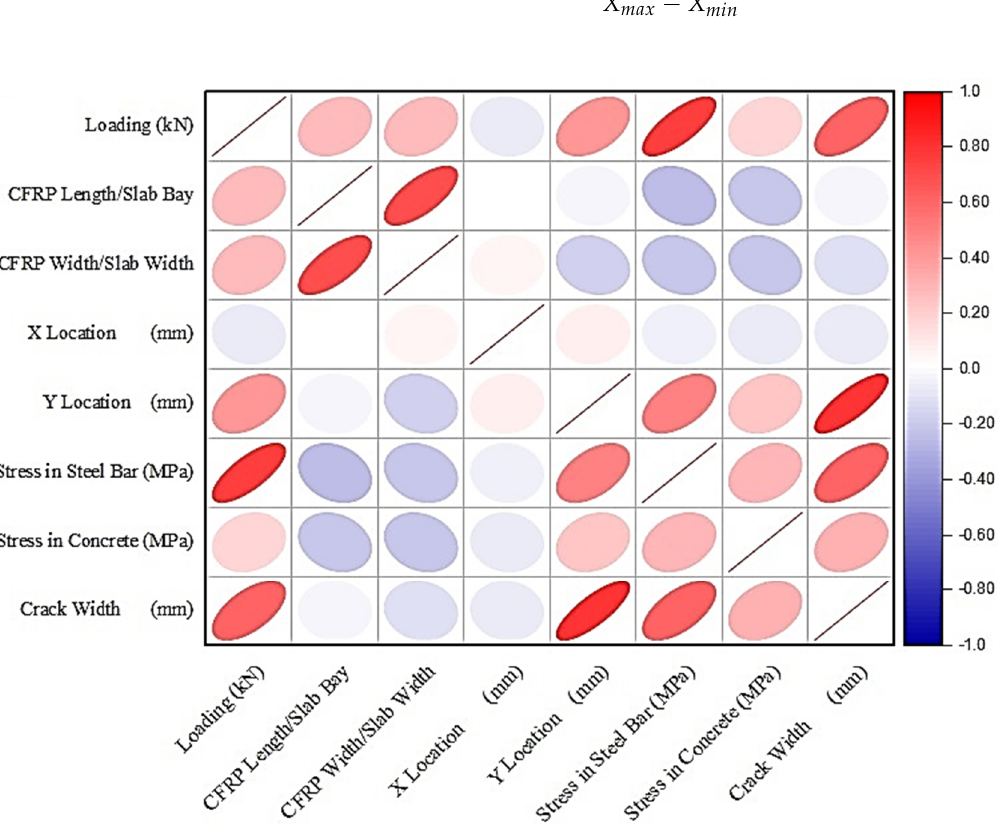
Figure 15. Correlation matrix between input and output parameters.